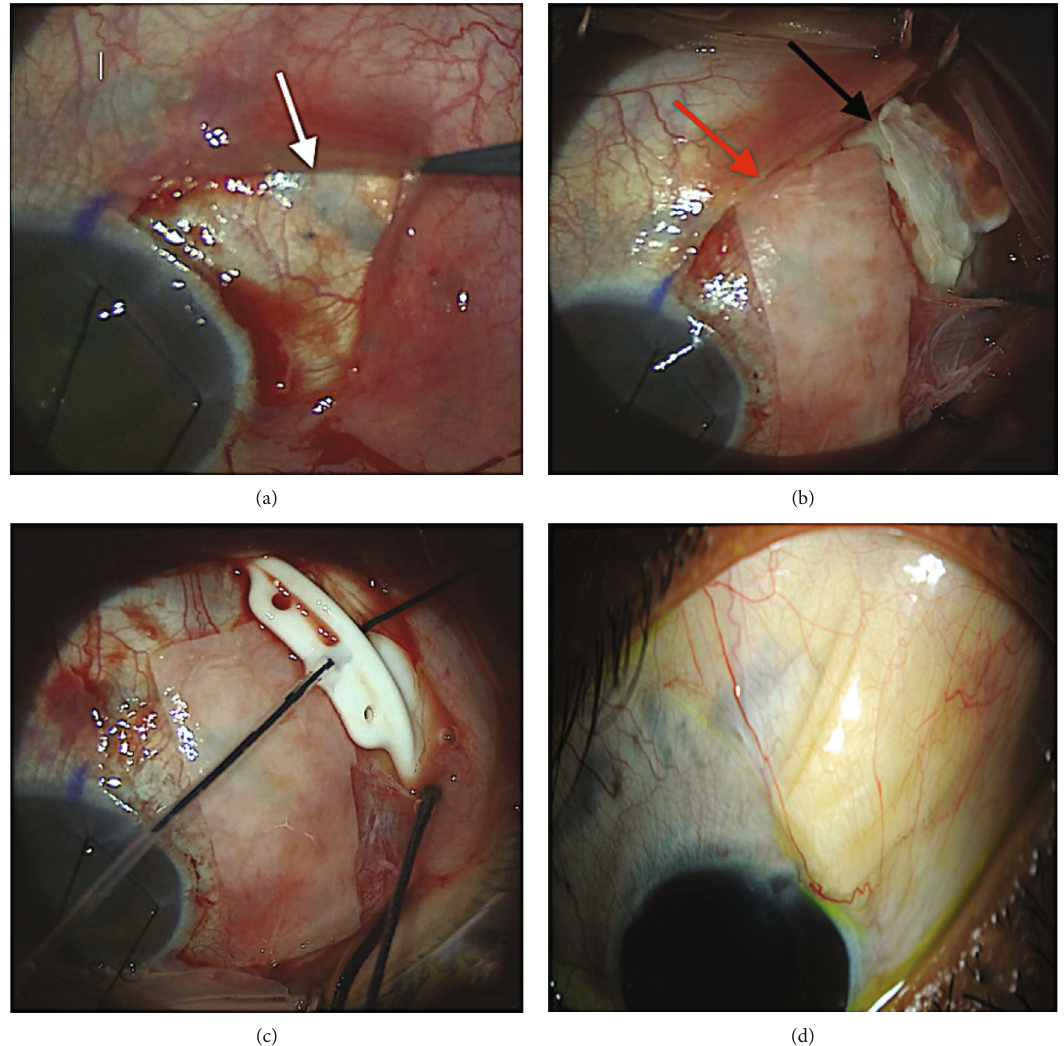
Figure 1: (a) shows scleral thinning evident after conjunctival dissection (white arrow). (b) shows Tutoplast Tm in place covering the bed of the plate (black arrow) and the tube (red arrow). (c) shows the plate and the tube in place over the Tutoplast Tm . (d) shows postoperative slit- lamp picture of the tube in place with over lying Tutoplast Tm